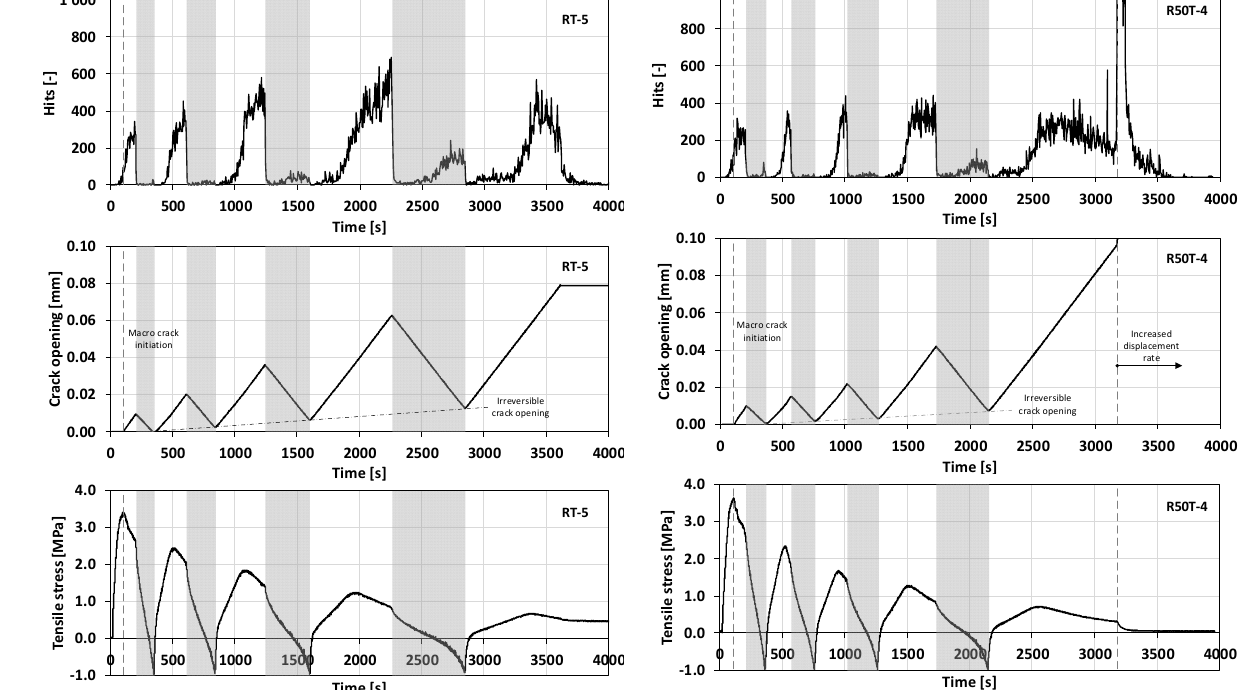
Figure 9. Cyclic tensile test results summarized as Hit ‐ time relation (upper), Crack opening ‐ time relation (middle) and Stress ‐ time relation (lower) for RT ‐ 5.